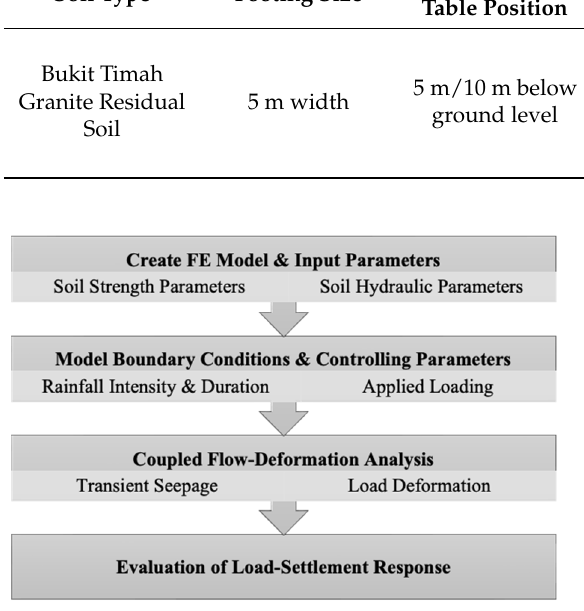
Figure 5. Sequential processes of finite element (FE) analysis.